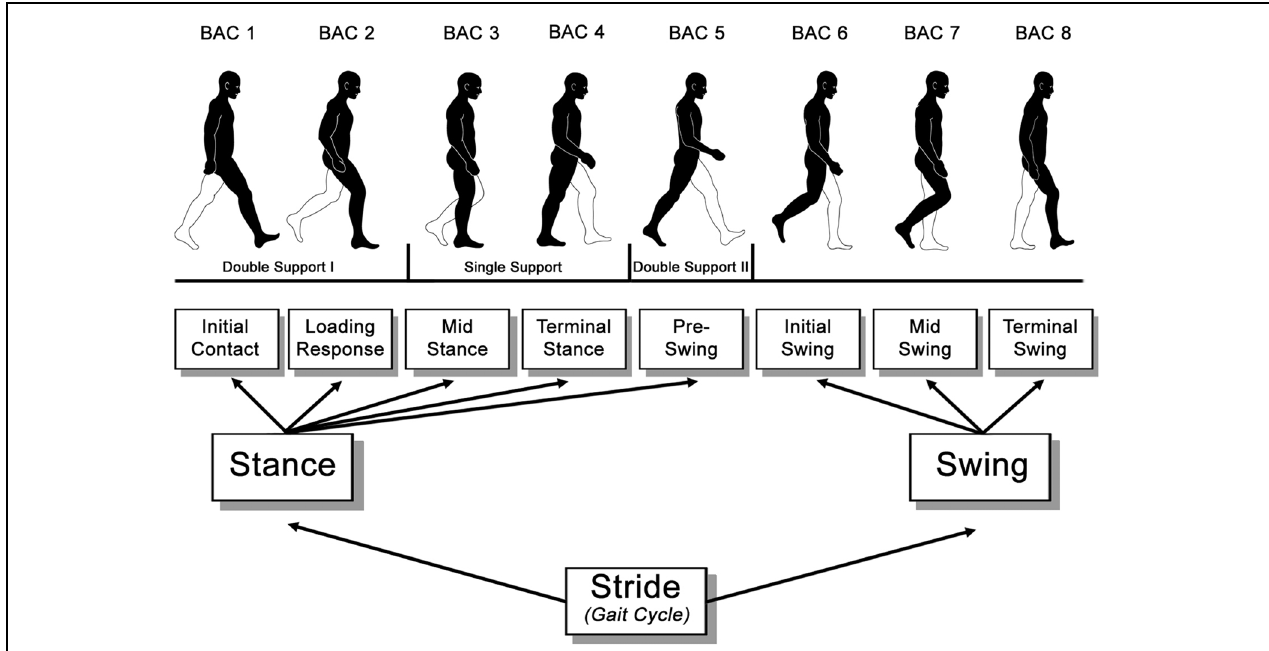
FIGURE 1 | Functional divisions of the gait cycle according to Perry and Burnfield (2010).